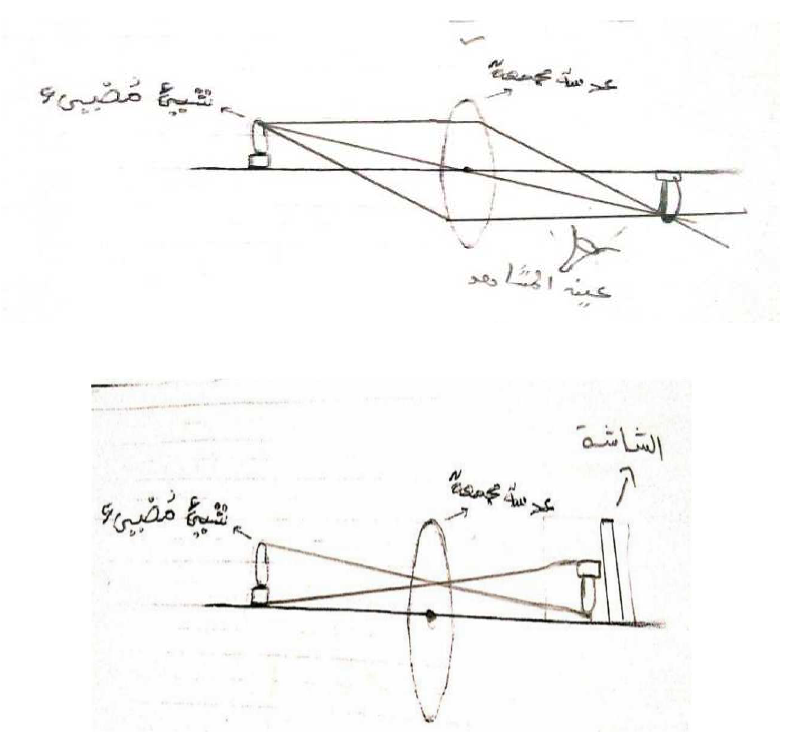
Figure .3 Conceptions des élèves à propos de Formation Figure .2 l’emplacement de l’œil de l’observateur, tracé par les élèves